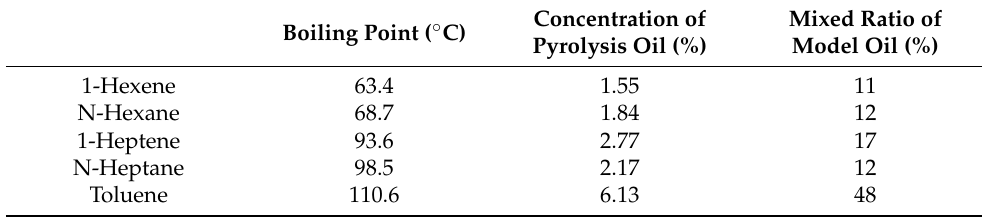
Table 1. Mixed model oil concentration.